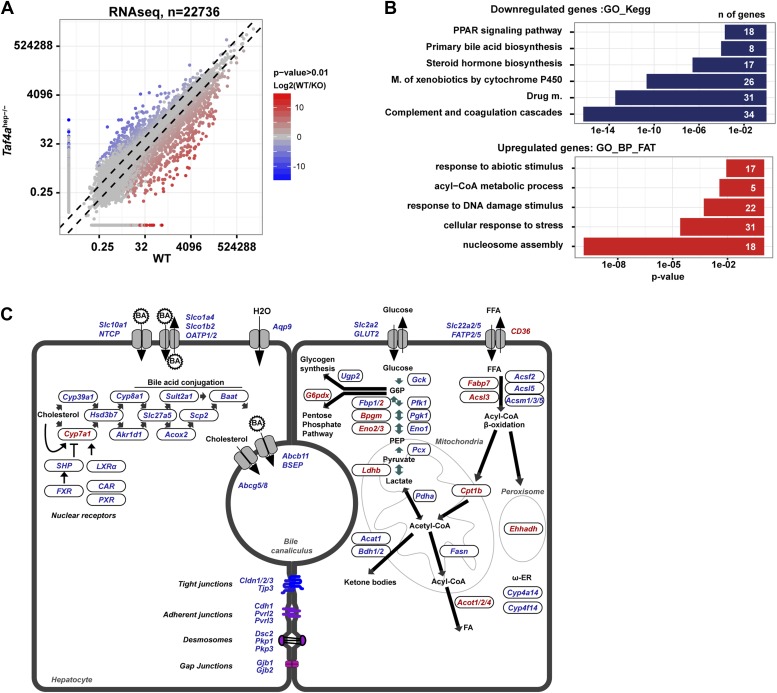
Deregulated gene expression in Taf4ahep−/− liver.(A) RNA-seq comparison of gene expression in WT and TAF4-mutant liver. (B) Ontology analysis of the up- and down-regulated transcripts. (C) Schematic integration of deregulated genes in metabolic pathways and cell structure. Down-regulated genes are in blue and up-regulated genes in red.